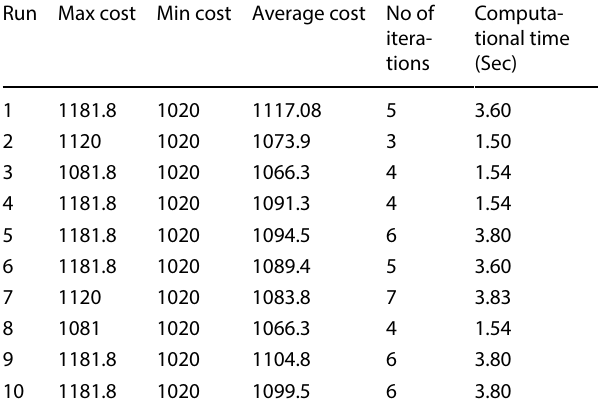
Table 1 statistical fitness results for axle mounting bracket problem